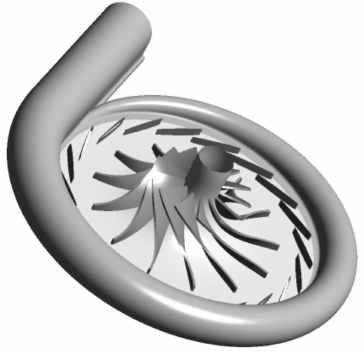
Figure 7. The final geometry of the designed RI turbine.